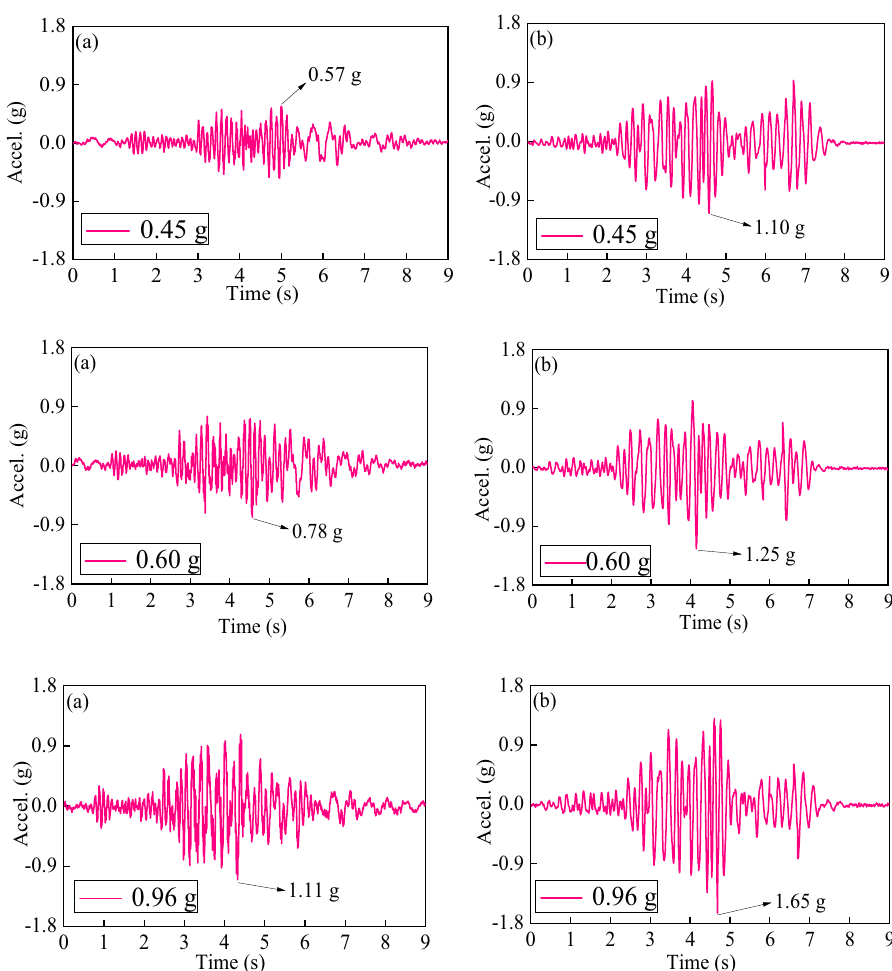
Figure 13. Time-history of acceleration at the top of M-1 pier specimen under different PGA. ( a ) x-direction, ( b )